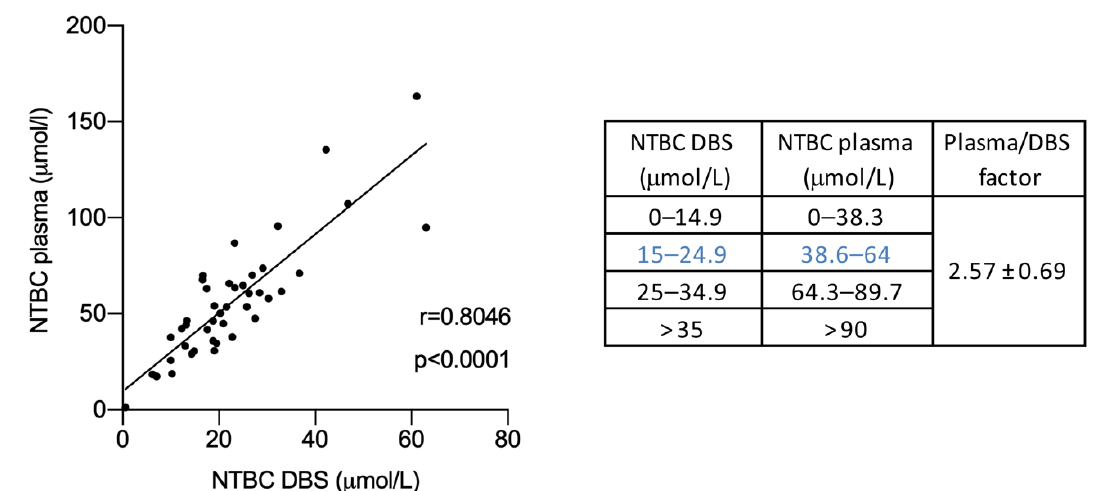
Figure 1. Correlation of the NTBC concentration for 43 plasma (umol/L) and DBS (μmol/L) samples ( r = 0.8046; p < 0.001; 95%CI 0.74 – 0.92). The complement table on the right shows the conversion values for each range with a factor of 2.57 ± 0.69. DBS, Dried blood spot. Table 2. NTBC concentration in plasma and DBS samples at two COVs for succinylacetone levels in urine. NTBC